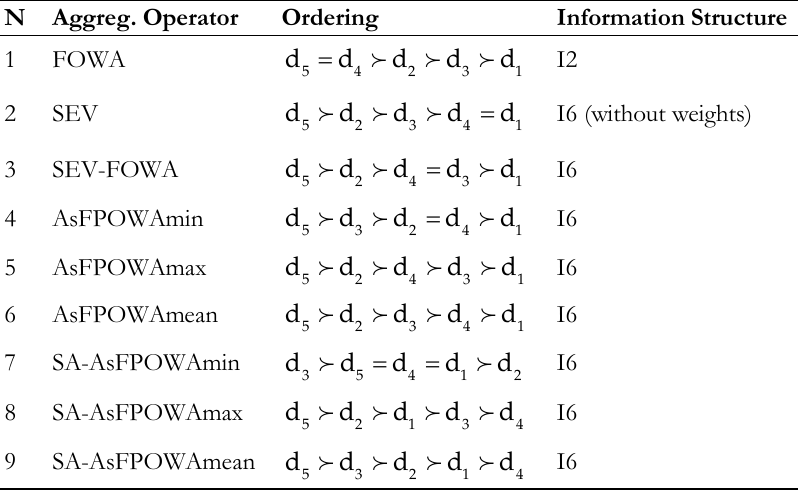
Table 8. Ordering of the